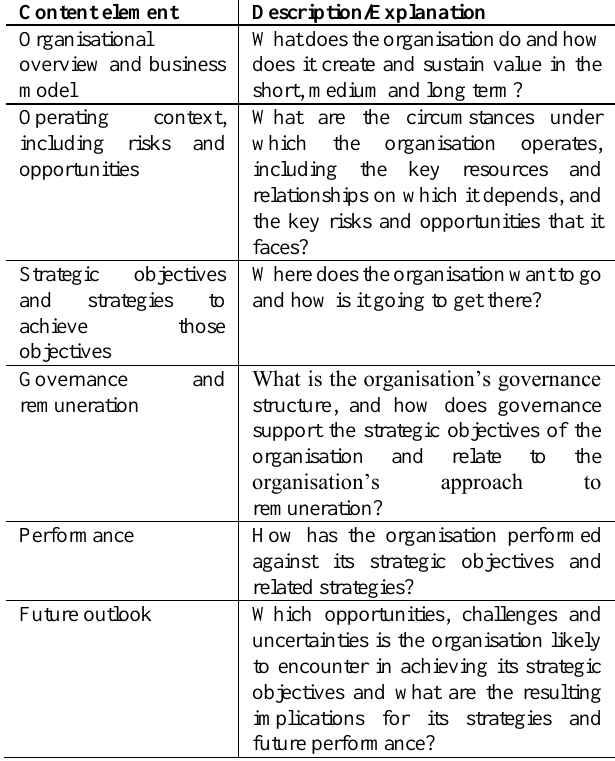
Table 1: Content elements of an integrated report, as suggested by the IRC of South